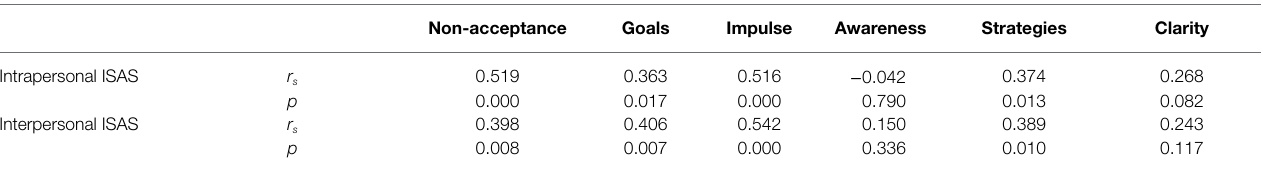
TABLE 3 | Associations (Spearman’s rho) between DERS subscales and ISAS factors in forensic psychiatric patients ( n =